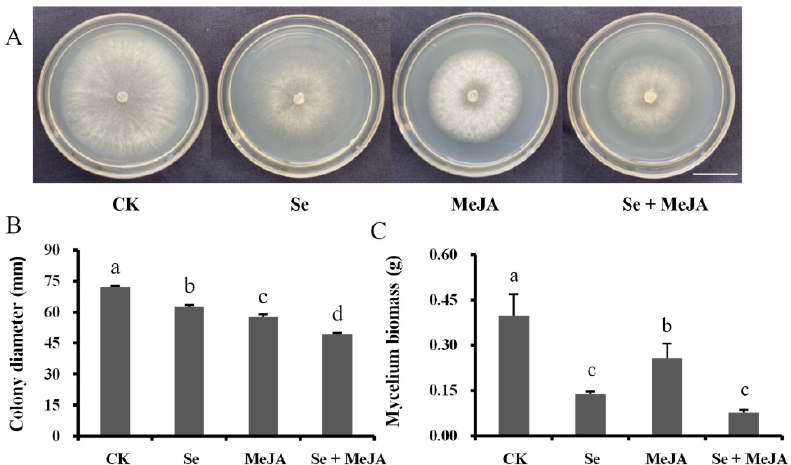
Figure 1. Effect of Se, MeJA and Se + MeJA on colony growth ( A ), colony diameter (n = 4) ( B ) and mycelium biomass (n = 4) ( C ) of Botrytis cinerea . CK: Control group; Se: 5.0 mg/L Se; MeJA: 0.4 mM MeJA; Se + MeJA: 5.0 mg/L Se with 0.4 mM MeJA. Columns followed by different lowercase letters are statistically different according to Duncan’s multiple range test ( p < 0.05). Bars = 22.5 mm.